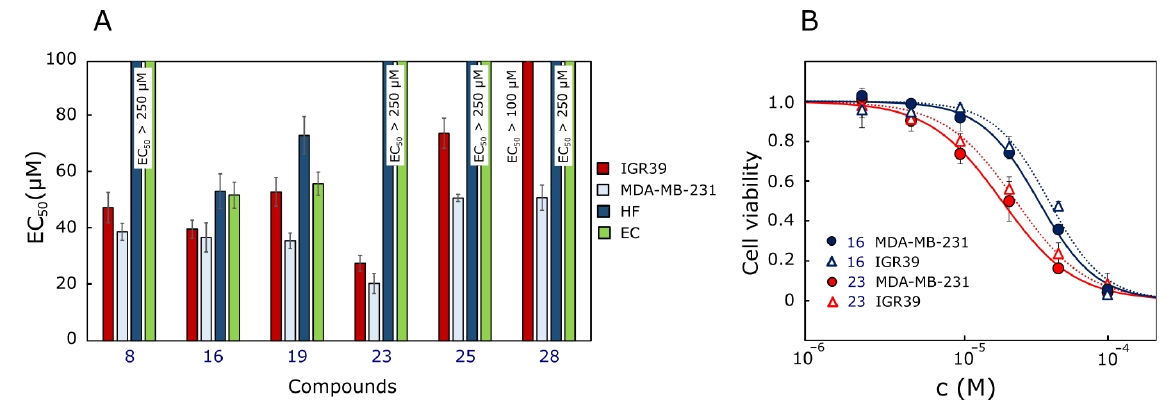
Figure 3. Effect of the most active compounds on cancer cell viability. ( A ). EC 50 values of the most active compounds after 72 h of incubation by MTT assay. ( B ). Dose–response curves of compounds 16 and 23. n = 3. Experiments were repeated three times, calculating the mean and standard deviation.